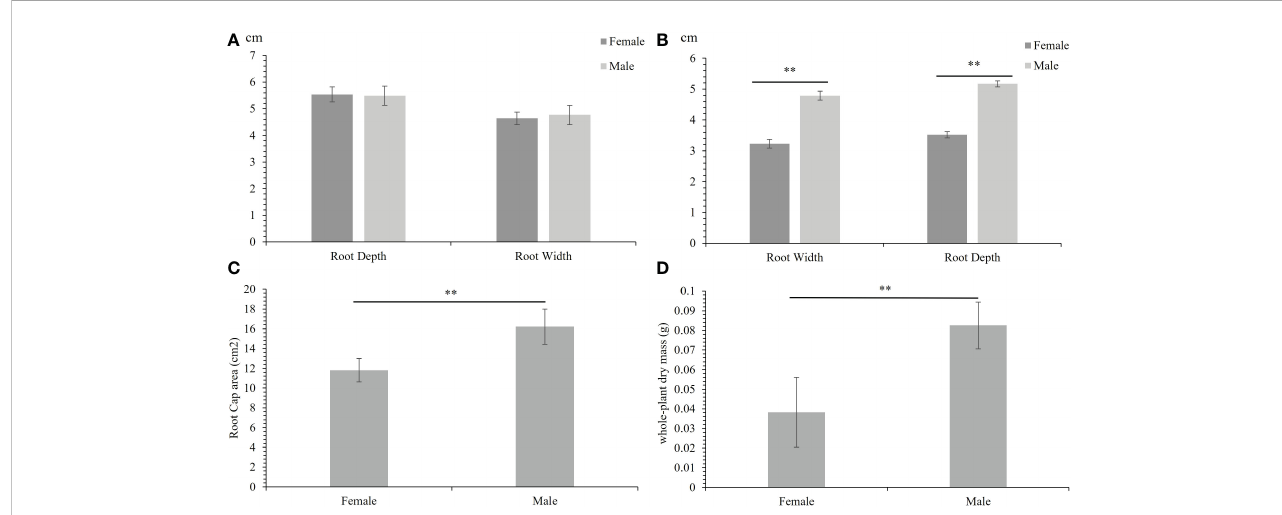
FIGURE 1 Females and males showed different responses to salinity stress. (A) The root depth and width of females and males under normal condition. (B) The root depth and width of females and males under salinity stress. (C) The root cap area of females and males under salinity stress. (D) The whole-plant dry mass of females and males under salinity stress. The error bars denote the standard error (SE), The phenotypes were signi fi cantly different at **p <